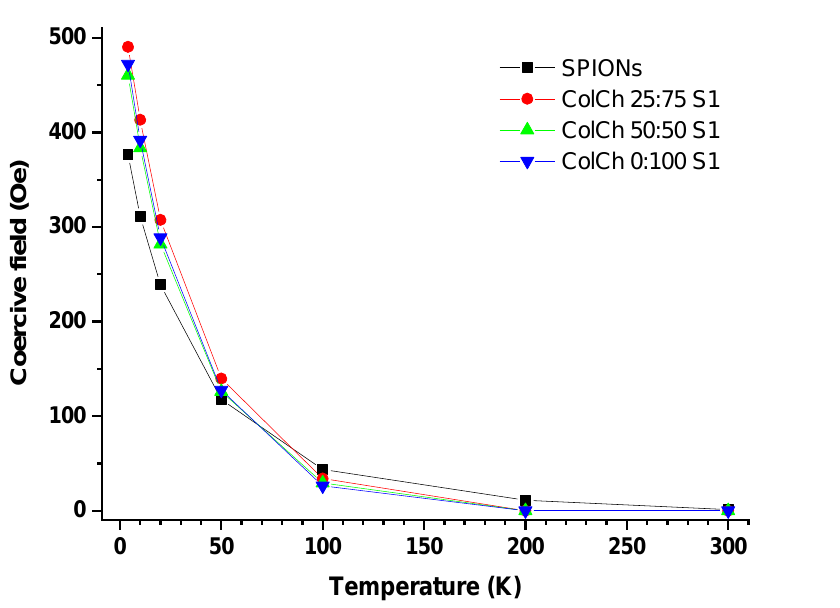
Figure 2. Temperature dependence of the values of the coercive field, Hc, for the materials stud- ied.